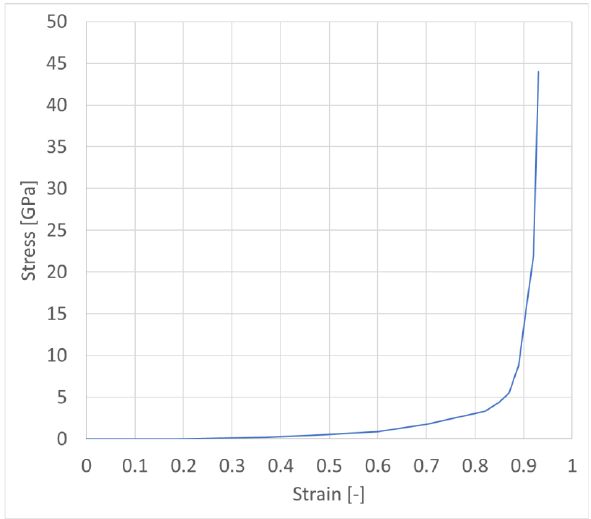
Figure 15. Stress vs. strain curve used to model the jellyroll material behavior.